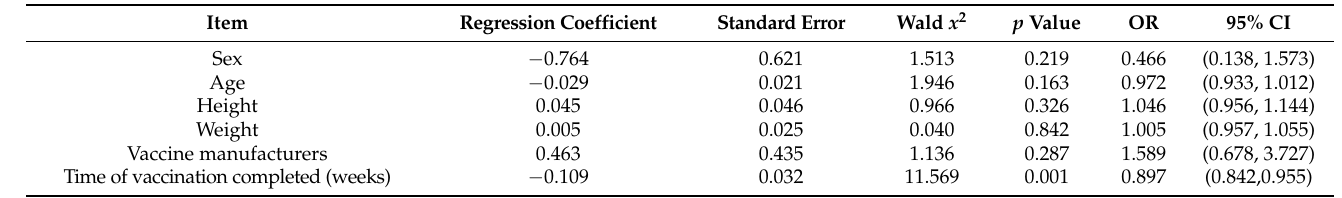
Table 4. Results of multivariate analysis of SARS-CoV-2 neutralizing antibodies by logistic regression